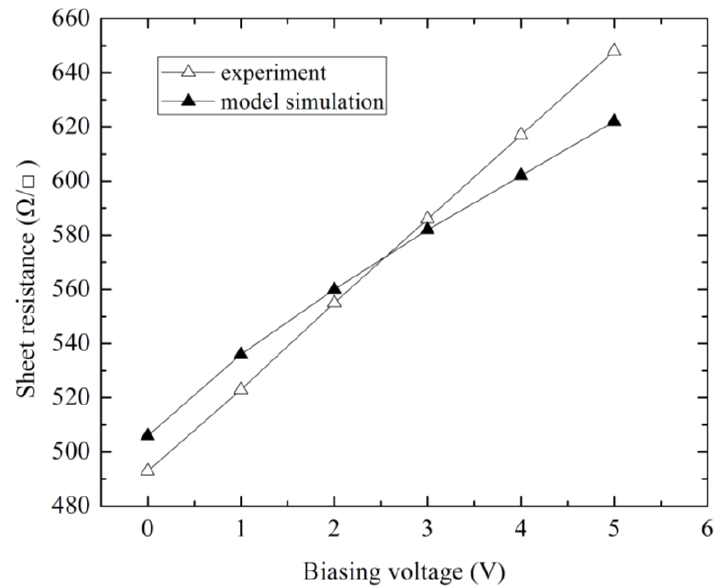
Figure 6. Comparisons between the measurements and the model simulation for the sheet resistance of N-well dependence of input